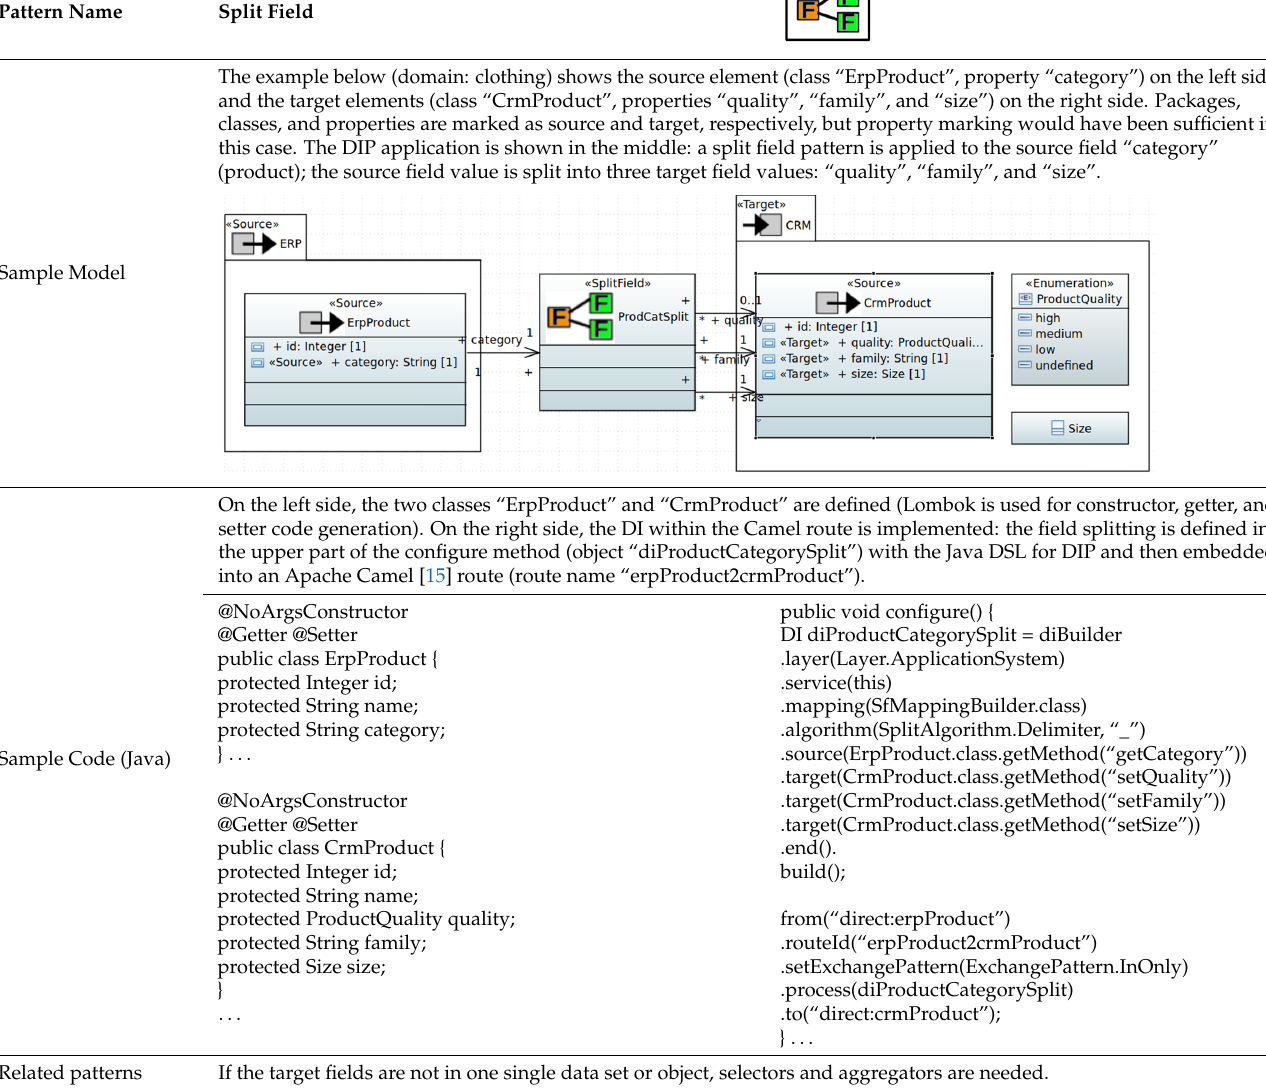
Table 2. Cont. Table 2. Detailed pattern definition for data integration pattern “Split